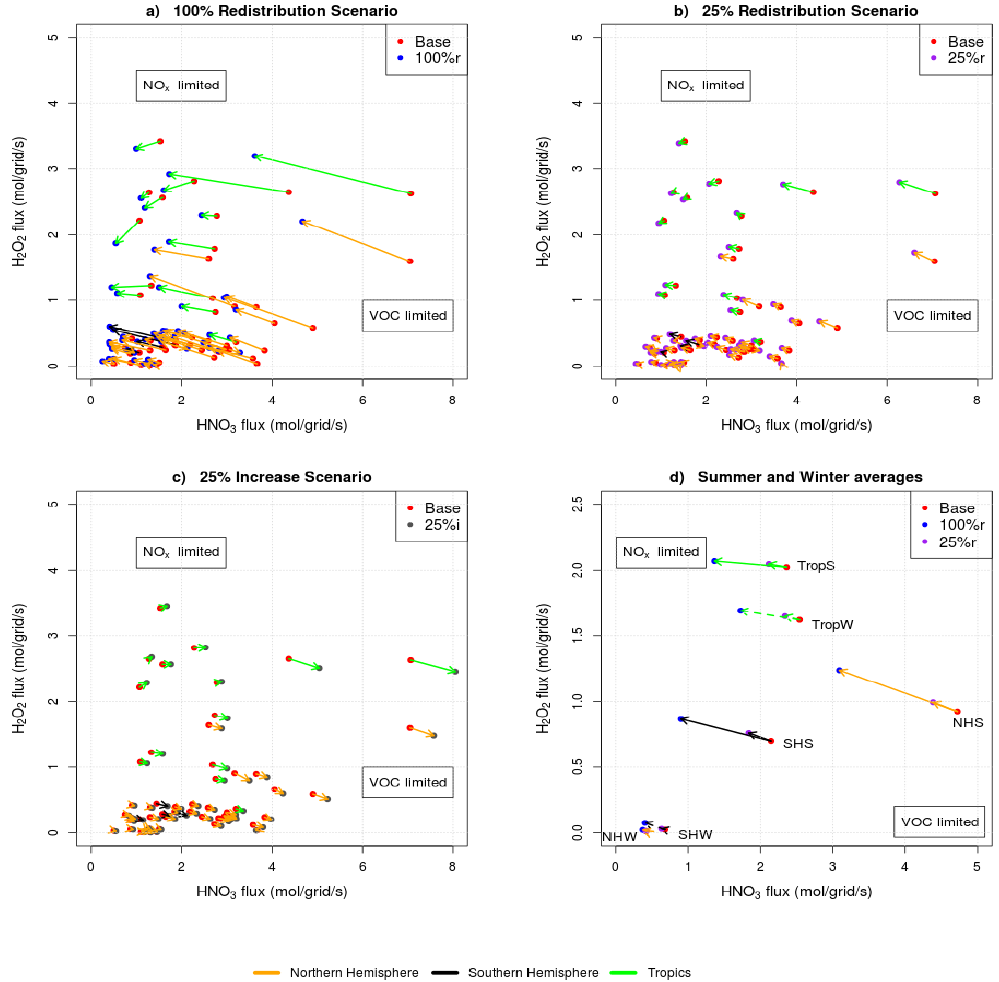
Fig. 5. (a–c) Annual average H 2 O 2 : HNO 3 formation up to 320m for individual megacity grid cells with the base ratio in red, (a) 100% redistribution in blue, (b) 25% redistribution scenario in purple and (c) 25% increase scenario in grey. Arrows link megacity grid cell changes from the base run to the scenario run. The colour of the arrow relates to latitude: orange arrows indicate Northern Hemisphere megacities, black arrows indicate Southern Hemisphere megacities and green arrows indicate megacities in the tropics. In (d) seasonal averages are shown for all megacity grid cells within the latitude band. Solid arrows represent summer changes, and dashed arrows represent winter changes. Lines are labelled as Northern Hemisphere megacities in summer (NHS) and winter (NHW), Southern Hemisphere megacities in summer (SHS) and winter (SHW) and tropical megacities in summer (TropS) and winter (TropW). Note the tropical megacity averages are plotted for boreal winter and summer. 37